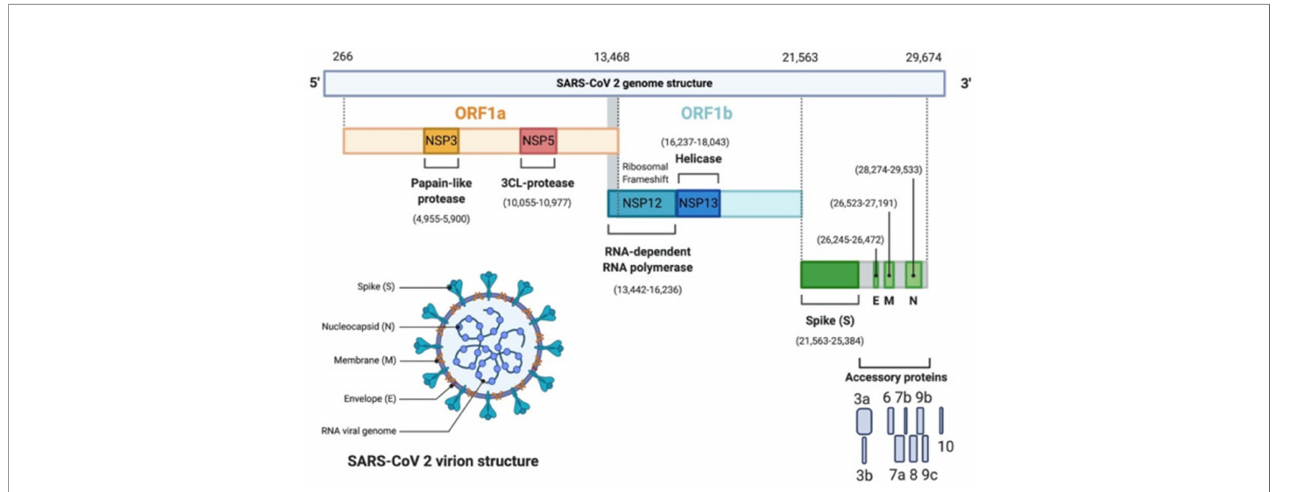
FIGURE 1 | SARS-CoV-2 genomic organization. SARS-CoV-2 genome contains 2 ORFs, ORF1a (yellow) and ORF1b encoding 16 non-structural proteins (NSP1- 16). NSP3 corresponds to the Papain-like protease, NSP5 the 3CL-protease, NSP12 the RNA-dependent RNA polymerase (RdRp), and NSP13 the helicase. It has 4 structural proteins: Spike (S), Envelope (E), Membrane (M) and Nucleocapsid (N) (green). S, E and M form the envelope, N associates with the viral genome. In grey, are the accessory proteins: 3a, 3b, 6, 7a, 7b, 8, 9b, 9c, 10. The viral genome is a 30 kb linear single-stranded RNA. Adapted with permission from Alanagreh et al. (Alanagreh et al.,